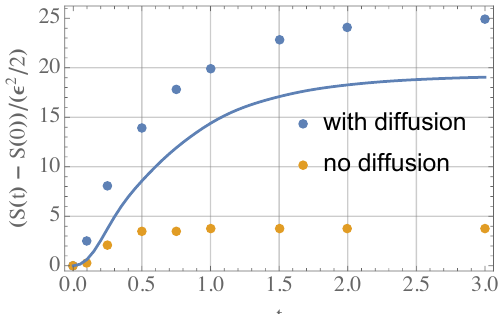
Figure 8: We plot the difference in the entropy between the state at time t and the initial state. The dots corresponds to evaluating the entropy from the definition (32) with the help of the numerical solution considered here. The solid line is computed with the GHD prediction for the entropy production (33). The discrepancy between the GHD predictions and observed entropy originates from linearization of the full dynamics.